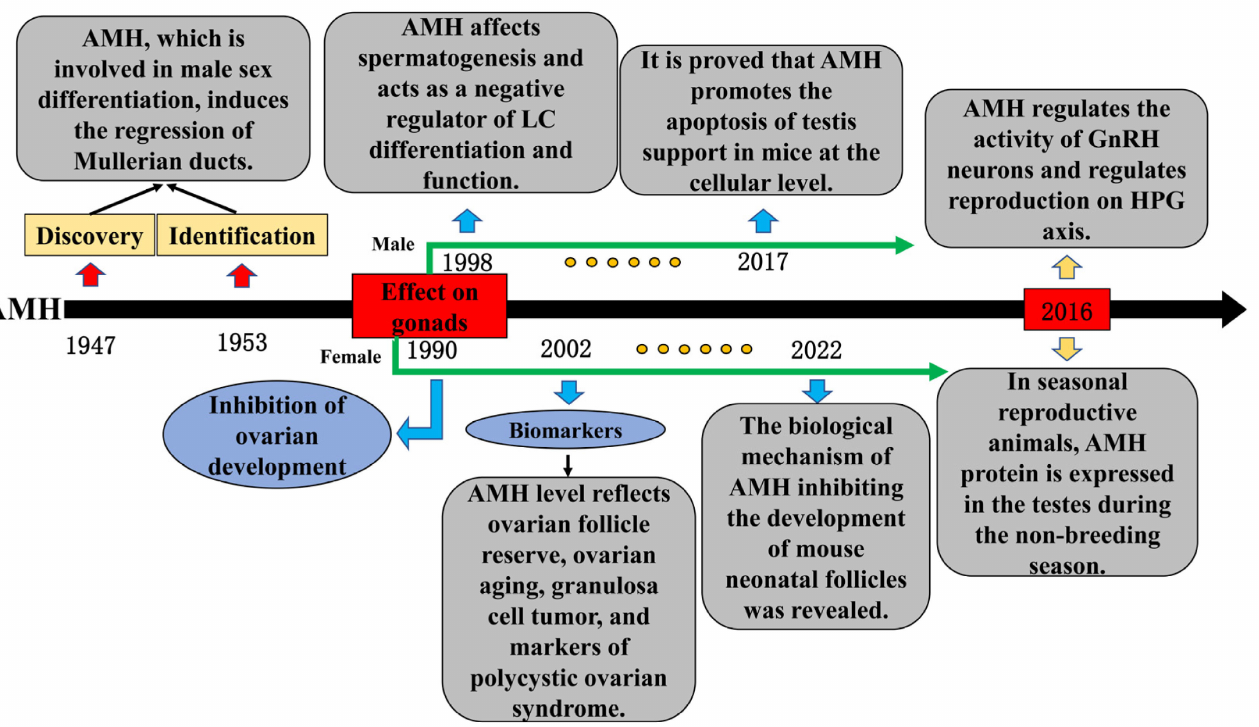
Figure 3. Important time nodes and research content in the progress of anti-Müllerian hormone (AMH)